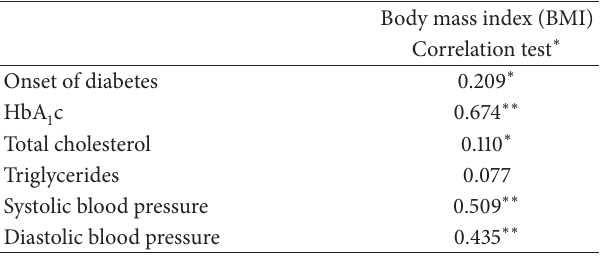
Table 5: Correlation between body mass index and metabolic and clinical parameters in type 2 diabetic patients ( 𝑛 = 545 ).